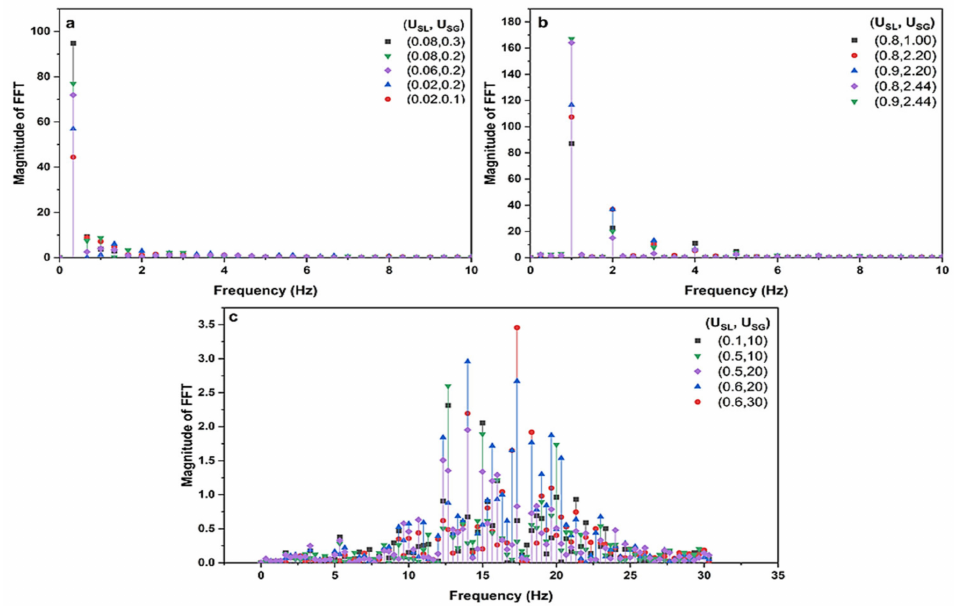
Figure 9. Fast Fourier Transform of the dynamic pressure signals of different flow regimes: ( a ) strati- fied, ( b ) slug, and ( c )